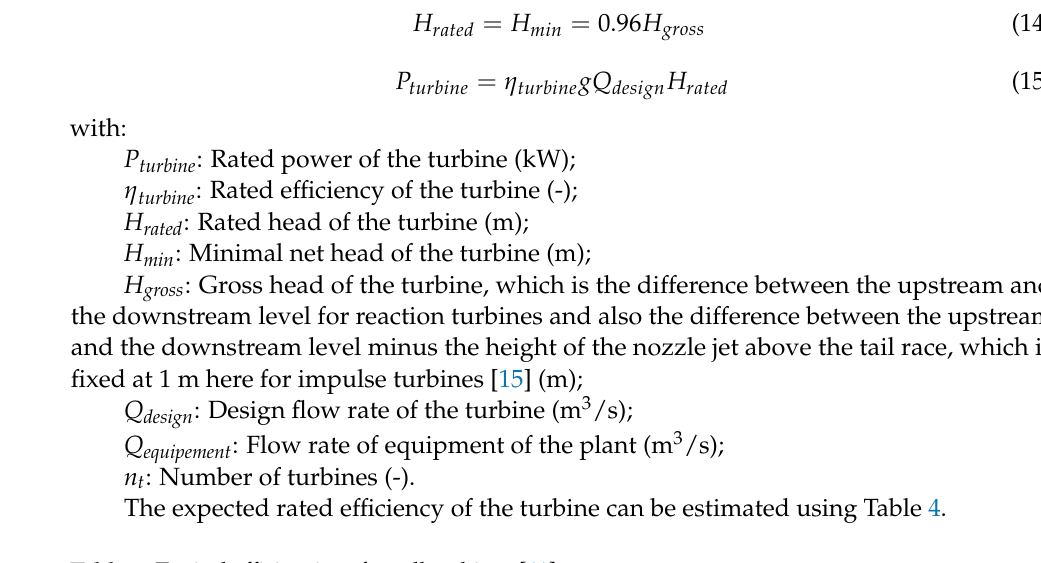
Table 4. Typical efficiencies of small turbines [41].